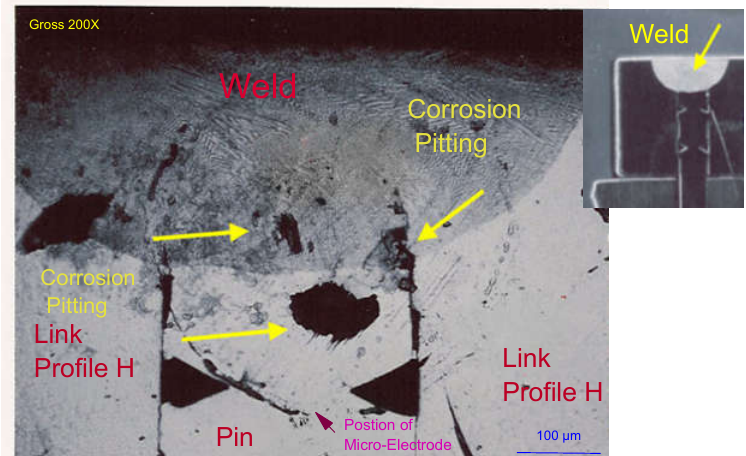
Figure 21. Microelectode positioned in weld/link/pin area, longitudinal surface. Optical examina- tion, magnification 40×, Sample #4.